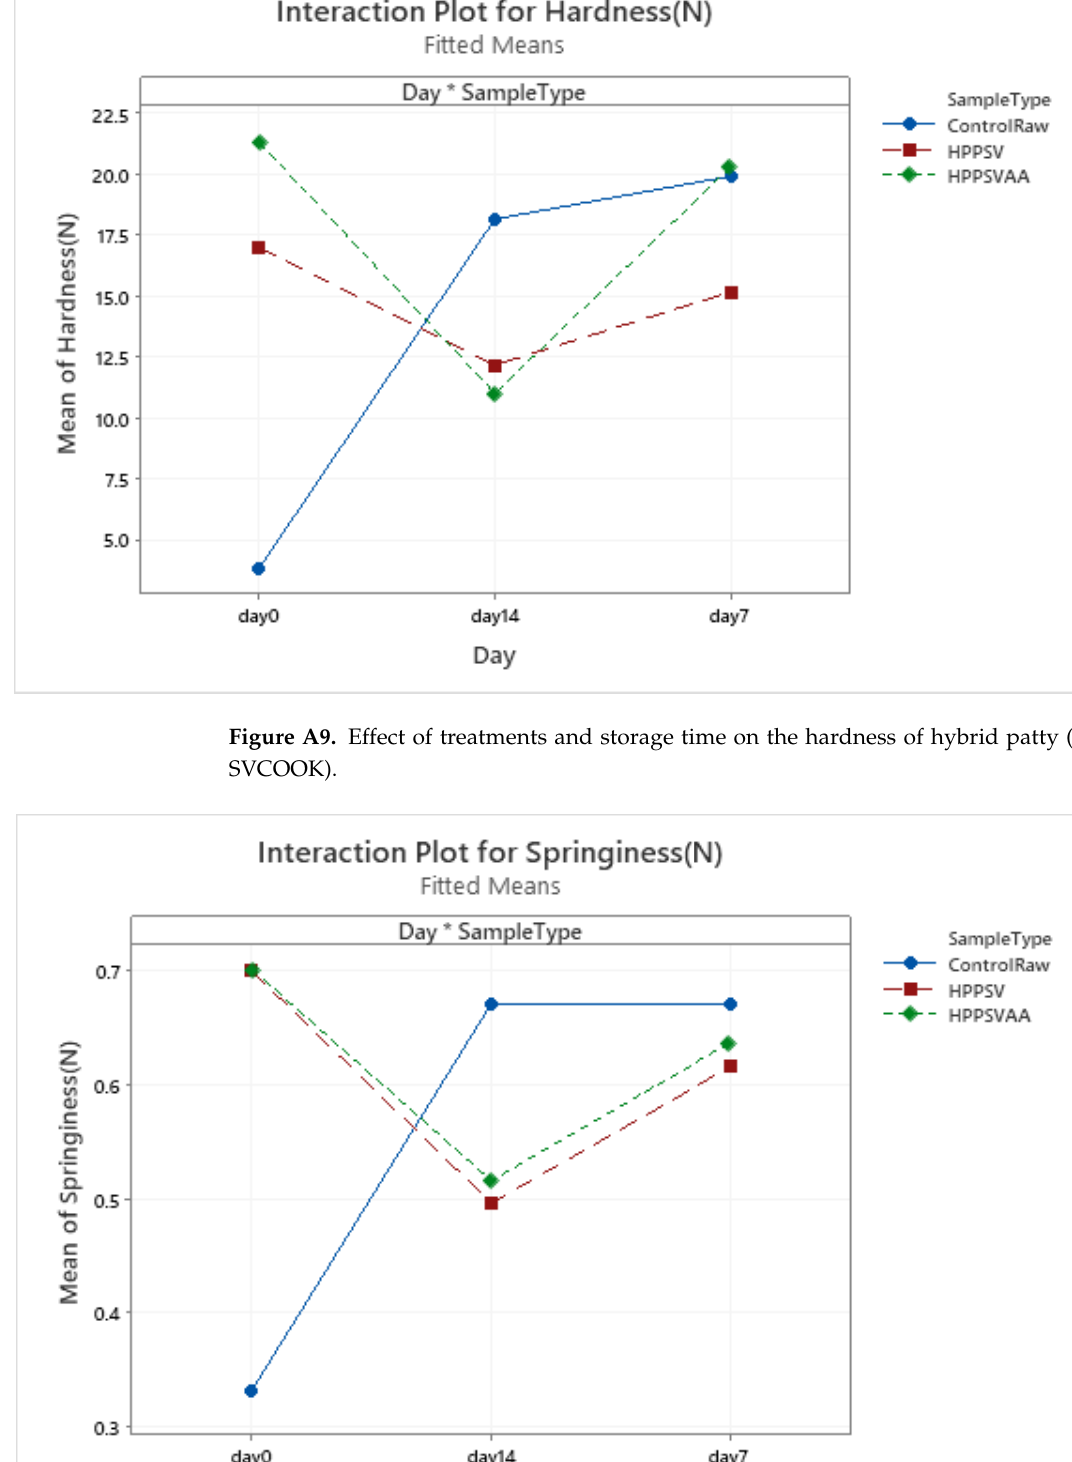
Figure A8. Effect of treatments and storage time on the chewiness of plant-based patty (HPPSV: HPP-SVCOOK).